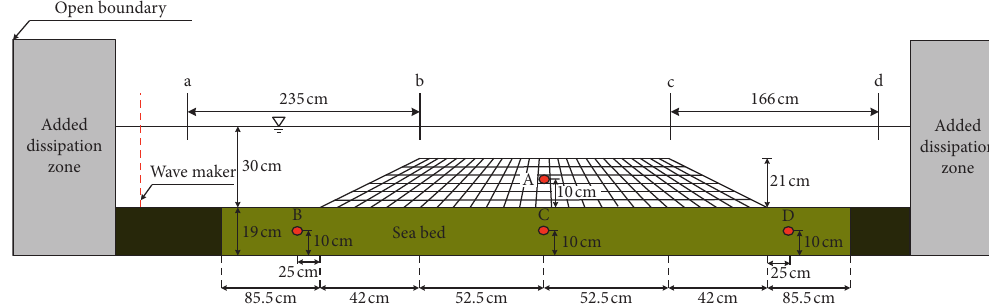
Figure 7: Schematic figure of the numerical wave-soil tank used in 2D-NIT and FLIP